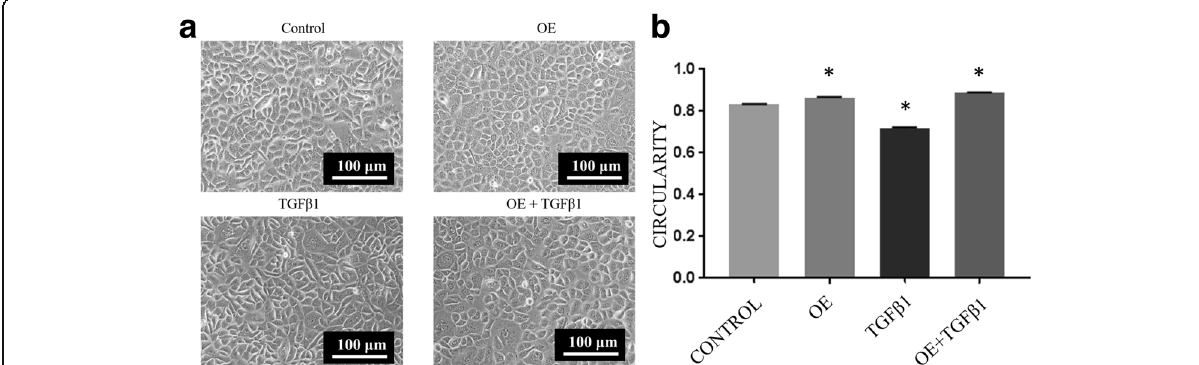
Fig. 3 a Morphology of untreated RECs (control), 0.05% OE-treated RECs (OE), RECs with EMT induced by 5 ng/ml TGF β 1 (TGF β 1) and RECs with EMT induced by TGF β 1 treated with OE (TGF β 1 + OE) on day 3. The TGF β 1 group displays a more elongated structure than the OE and TGF β 1 +